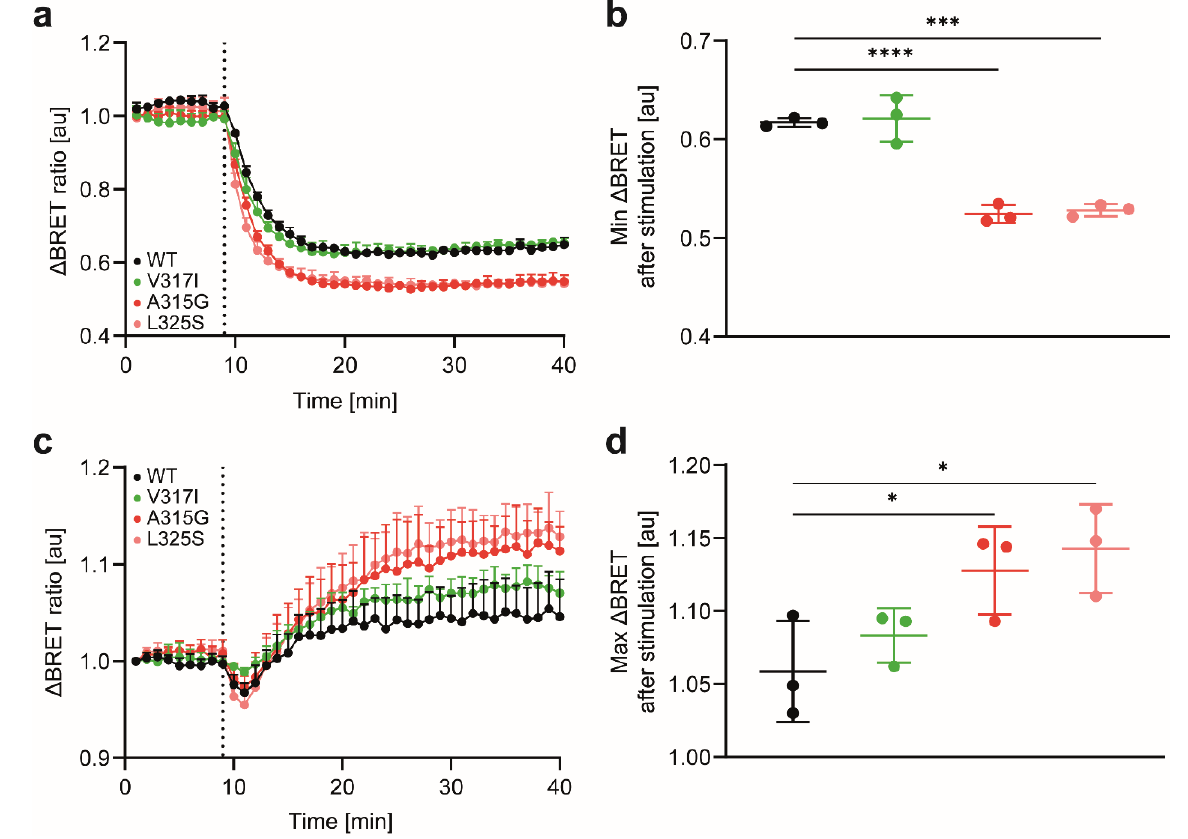
Figure 4. Shifting CCR7 to its monomeric form enhanced receptor internalisation and trafficking to early endosomes: ( a ) receptor internalisation determined by loss of BRET between the receptor and the plasma membrane marker rGFP-CAAX. HeLa cells were transiently co-transfected with CCR7 variants fused to RLuc8 and rGFP-CAAX. At time-point 9 min, cells were stimulated with 1 µ M CCL19 (dotted line); ( b ) minimal ∆ BRET values after CCL19 stimulation for each receptor were quantified; ( c ) receptor trafficking to early endosomes determined by BRET. HeLa cells were transiently co-transfected with CCR7 variants fused to RLuc8 and rGFP-FYVE. At time-point 9 min, cells were stimulated with 1 µ M CCL19 (dotted line); ( d ) maximal ∆ BRET values after CCL19 stimulation for each receptor were quantified. ( a – d ) n = 3, mean ± SD, statistical analysis: one-way ANOVA. * p < 0.05; *** p < 0.01; **** p <